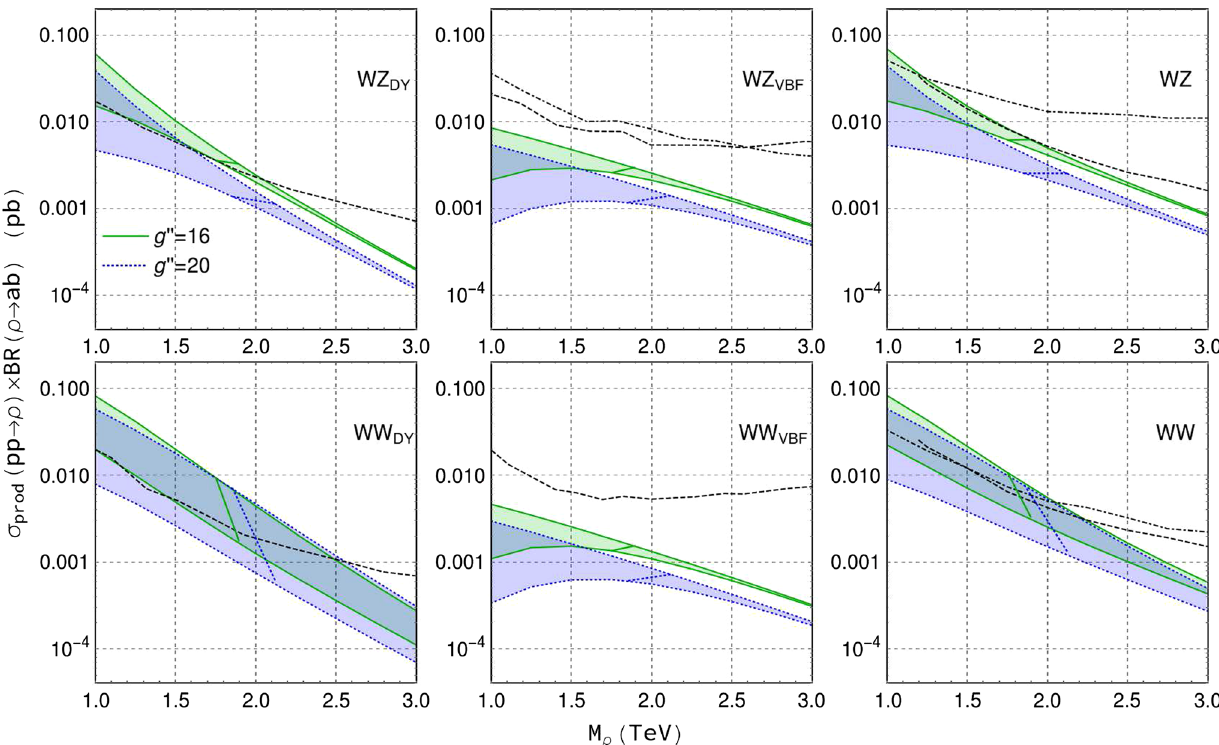
Fig. 10 The bands of possible values of σ prod × BR predicted by the tBESS model for the WW and W Z channels produced via the DY, VBF and DY+VBF production modes. The bands are constructed for g (cid:2)(cid:2) = 16 (solid green) and g (cid:2)(cid:2) = 20 (dotted blue) when the direct inter- action parameters are restricted to | b L , R | ≤ 0 . 1 and 0 ≤ p ≤ 1. The